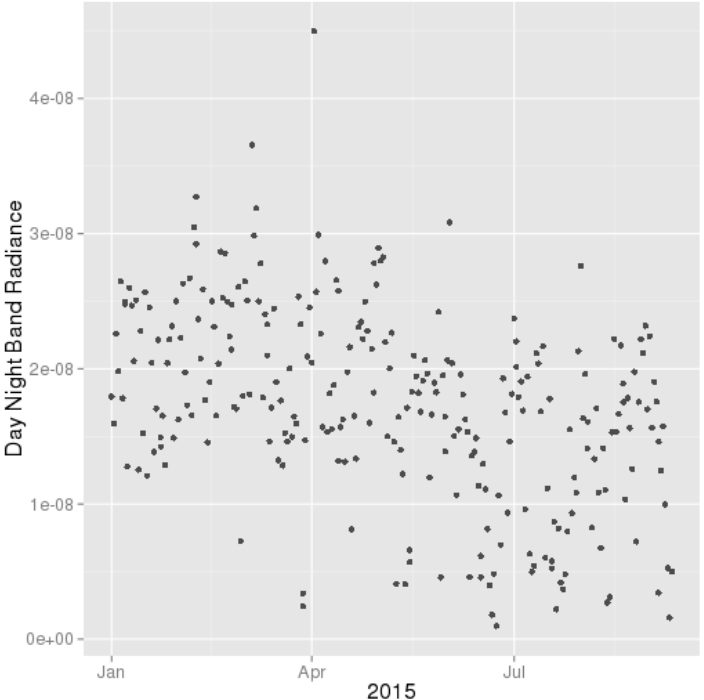
Figure 2. Daily DNB radiance values for Saharkar Nagar for the period 1 January 2015 to 9 September 2015. Time series plot of observed radiance values ( black dots ) for the study period.